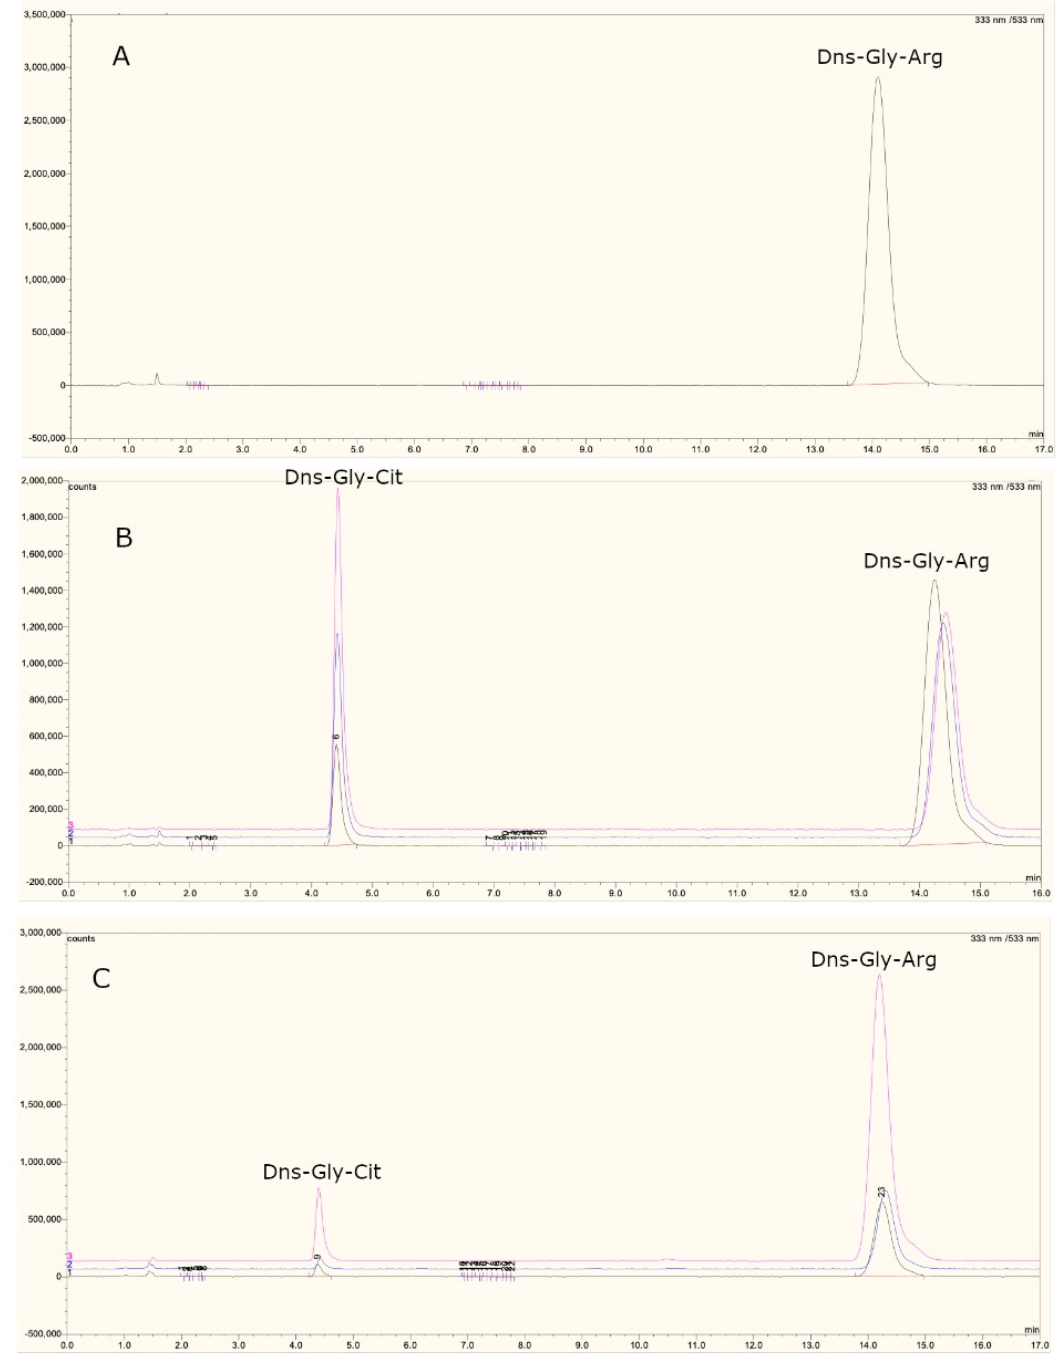
Figure 3. Fluorescent elution patterns of the reaction products generated by type PAD in PBMC and PMN lysates. ( A ) 20 mM Dns-Gly-Arg; ( B ) incubation with recombinant PAD enzyme in the presence of 20 mM Dns-Gly-Arg; ( C ) Incubation of 20 mM Dns-Gly-Arg with PMN and PBMC lysate from RA patients. The arrow indicates the peak corresponding to Dns-Gly-Cit.